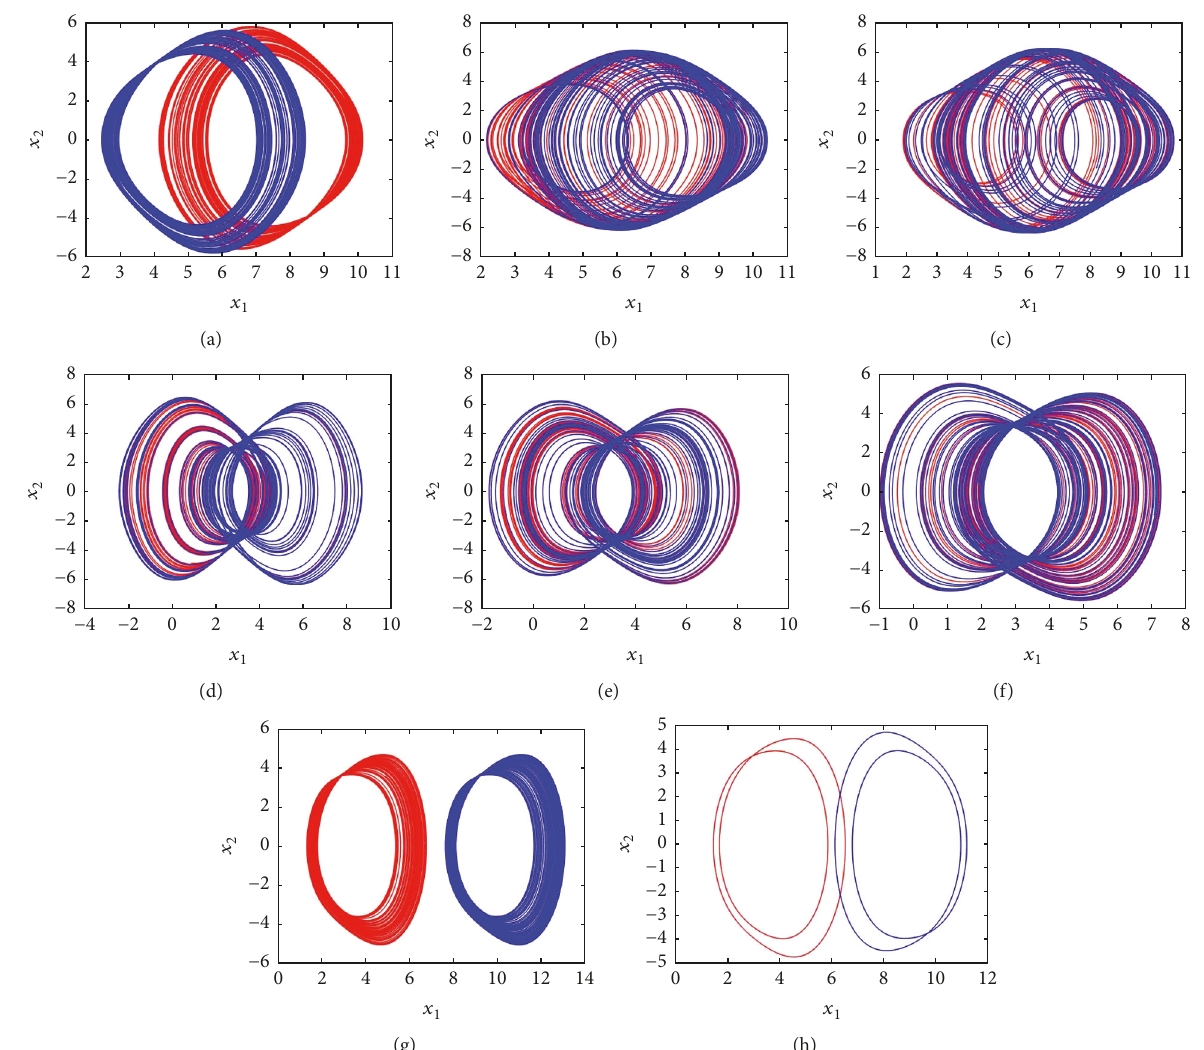
Figure 12: Coexisting attractors of the TDAHPS for various values of parameter ℎ 𝜏 . (a) ℎ 𝜏 = 10 ; (b) ℎ 𝜏 = 10.5 ; (c) ℎ 𝜏 = 11 ; (d) ℎ 𝜏 = 11.5 ; (e) ℎ = 12 ; (f) ℎ = 12.5 ; (g) ℎ = 12.8 ; (h) ℎ = 13 . 𝜏 𝜏 𝜏 𝜏